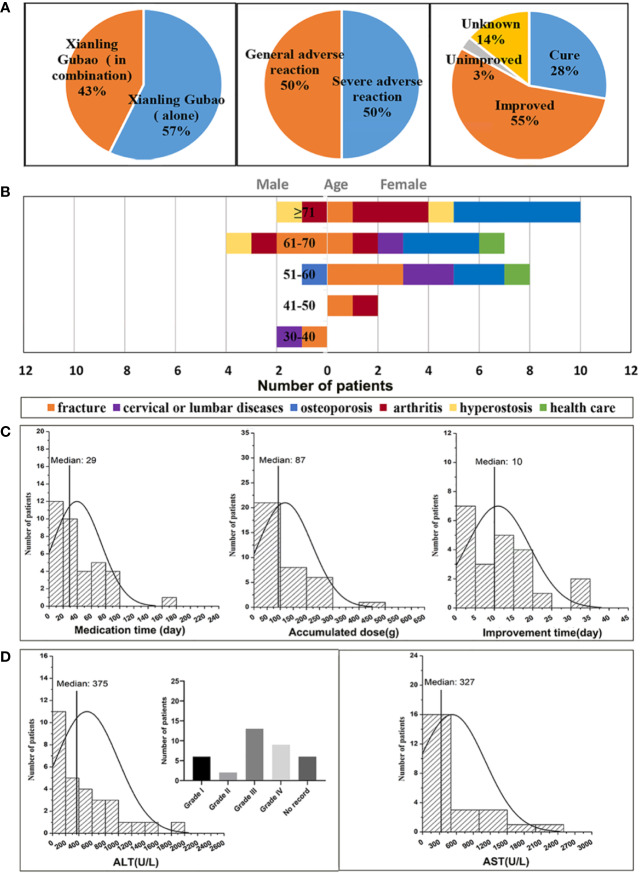
Analysis of clinical features of XLGB-induced liver injury (A) the incidence of XLGB-induced liver injury, drug compatibility, degree of adverse drug reaction, prognosis; (B) gender, age, and the purpose of medications; (C) Medication time, accumulated dose and improvement time; (D) biochemical indicators (ALT and AST).